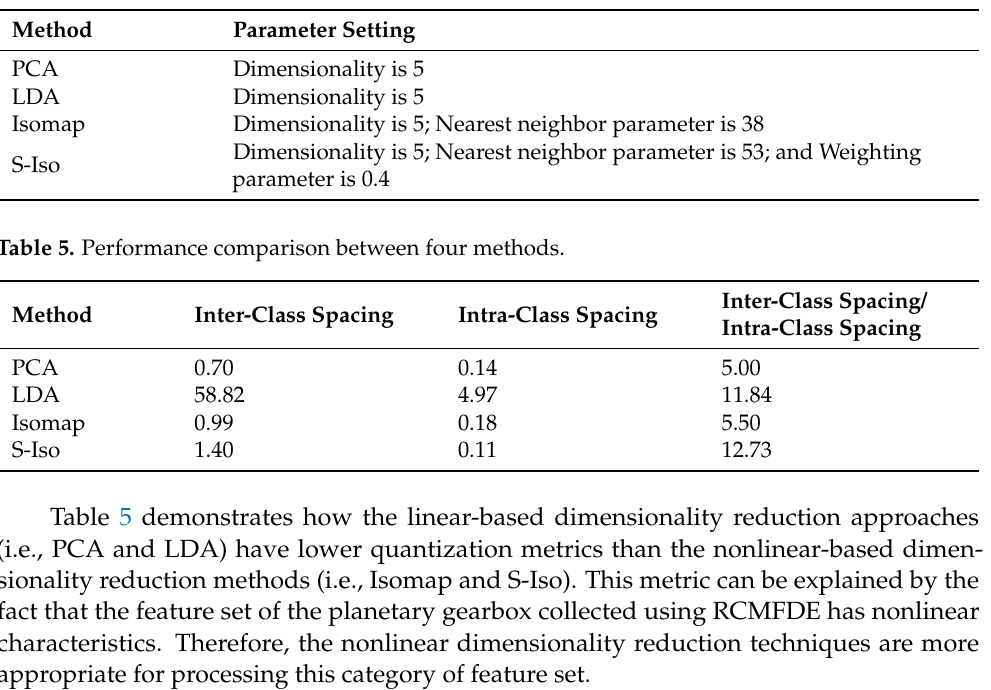
Figure 13. Dimensionality reduction results using four methods. Table 4. Parameter settings for different dimensionality reduction methods.